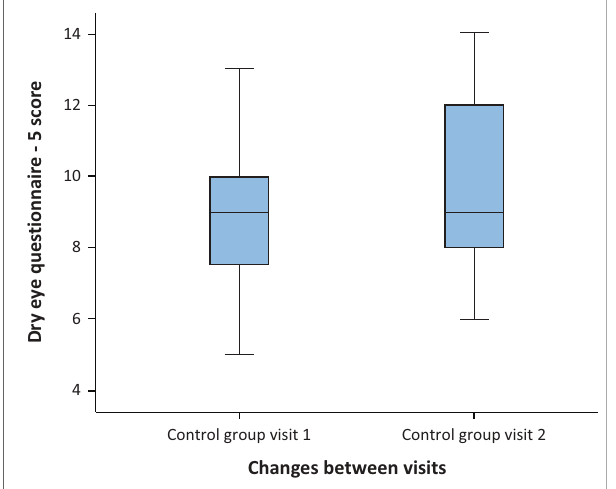
FIGURE 4: Box plots for Dry Eye questionnaire 5 score for the intervention group. No significant changes between visits.